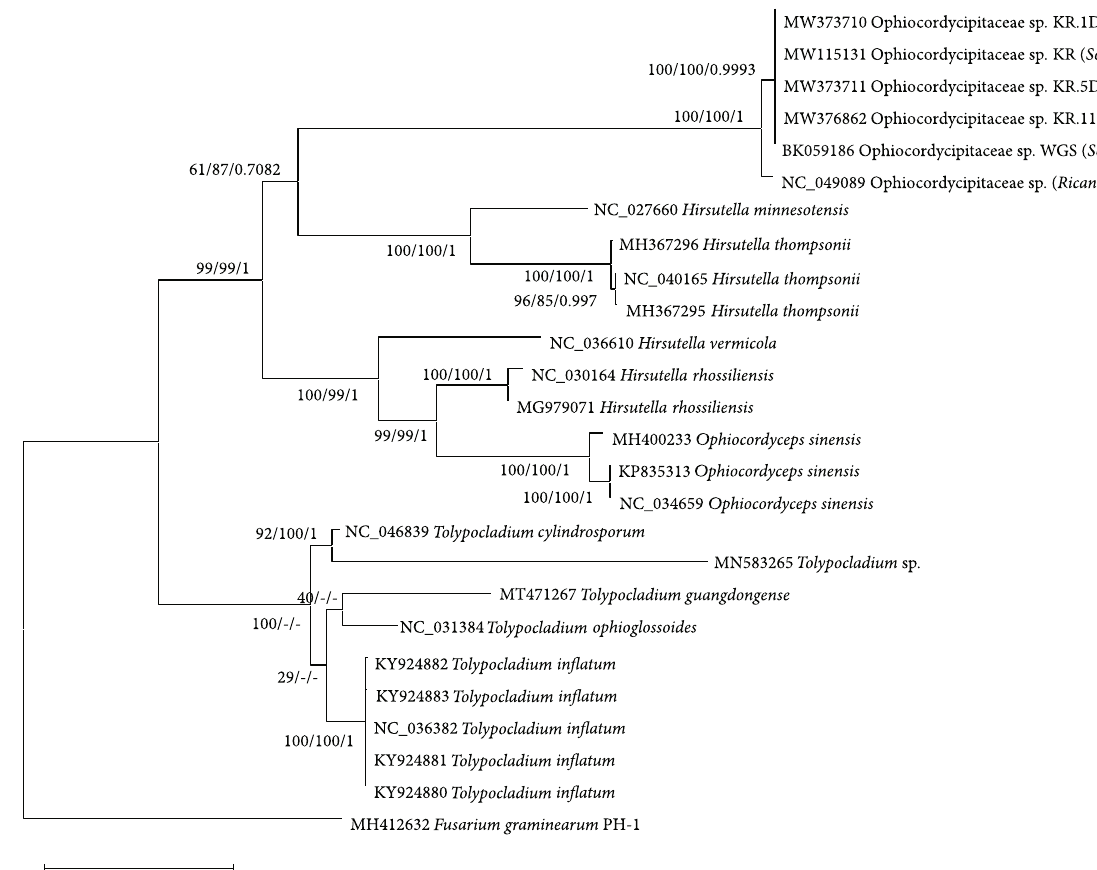
Figure 5: Phylogenetic trees of 26 fungal complete mitogenomes in Ophiocordycipitaceae. Neighbor-joining (bootstrap repeat is 10,000) and maximum-Likelihood (bootstrap repeat is 1000) phylogenetic trees as well as Bayesian inference tree (1,100,000 generations) of 26 fungal mitogenomes of Ophiocordycipitaceae. Phylogenetic tree was displayed based on the maximum-likelihood tree. The numbers above branches indicate bootstrap support values of maximum-likelihood and neighbor-joining phylogenetic trees and posterior possibility value of Bayesian inference tree, respectively. Scienti fi c names inside the parenthesis indicate those of host